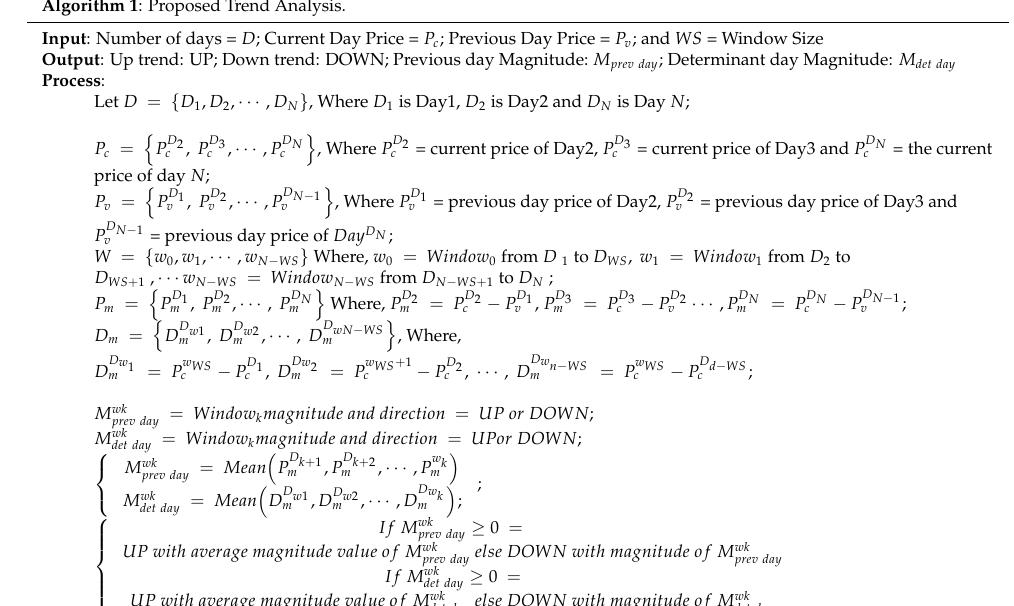
Algorithm 1 : Proposed Trend Analysis.